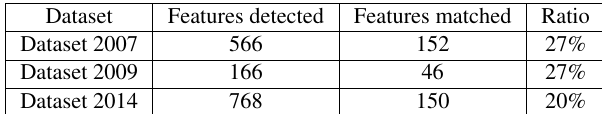
Table 2: Comparison of number of features detected and fused in the navigation filter